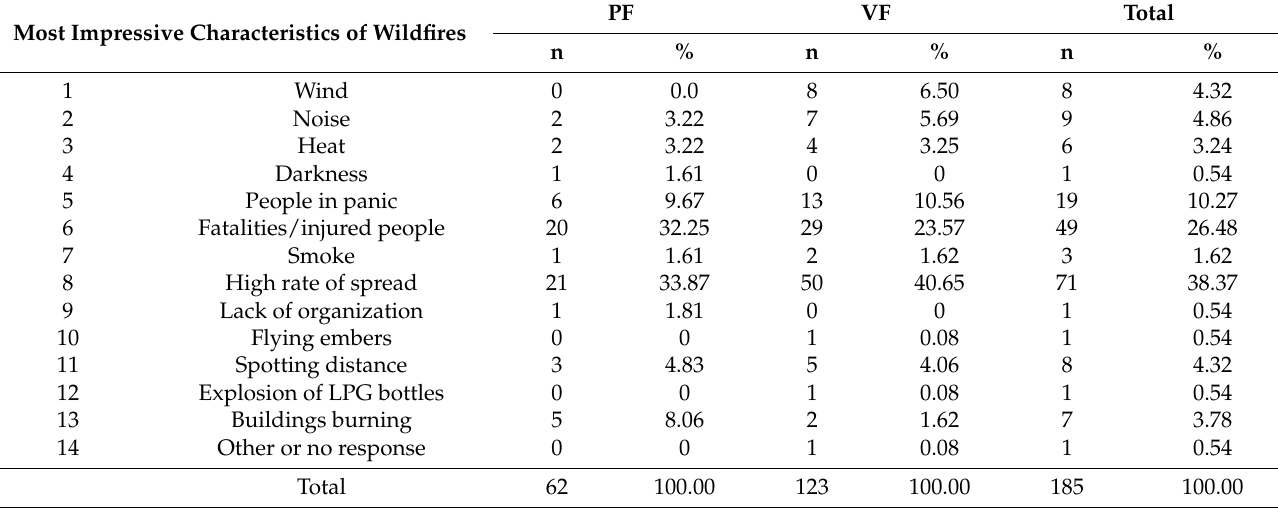
Table 4. Most impressive characteristics of